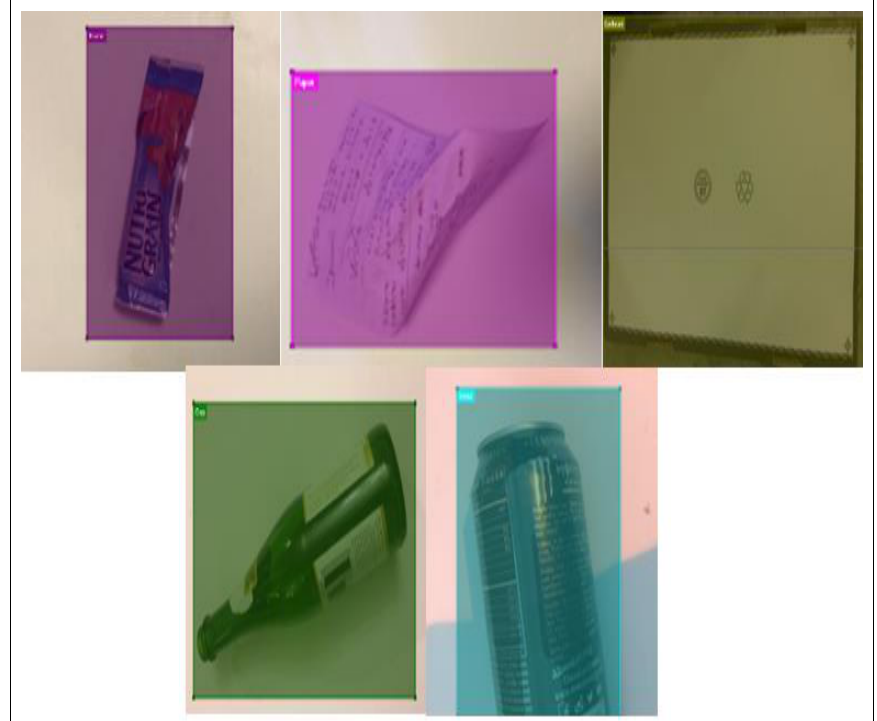
Figure 18. Correctly Classified Junk by Faster